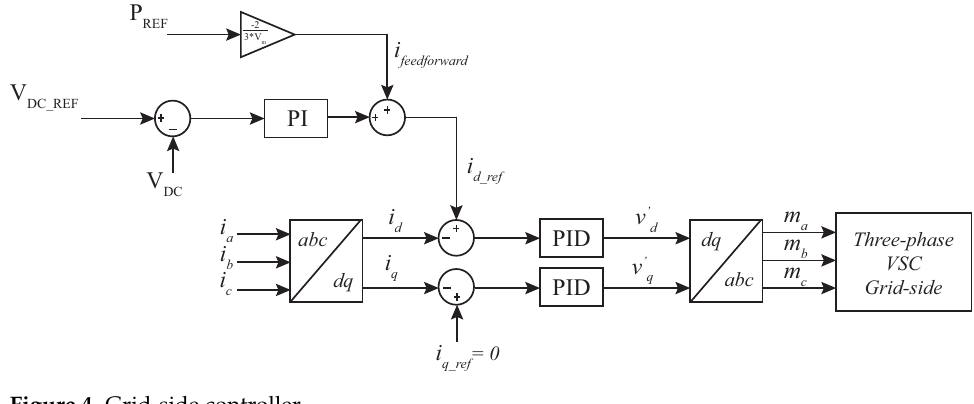
Figure 4. Grid-side